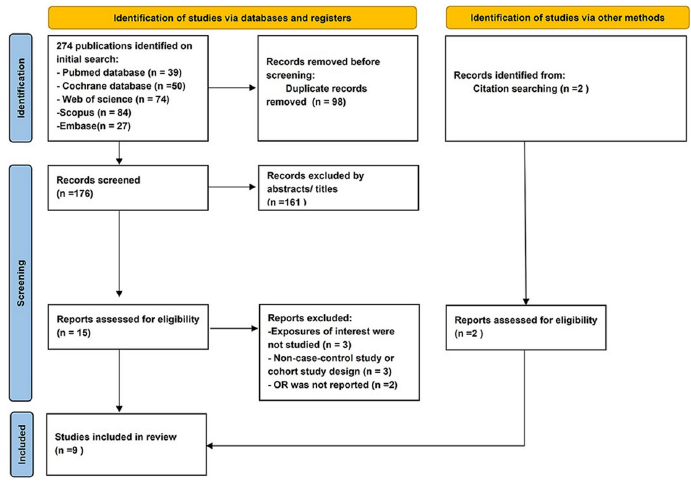
Fig 1. Prisma 2009 flow diagram literature search and study selection. PRISMA diagram showing the different steps of systematic review, starting from literature search to study selection and exclusion. The reasons for exclusion are indicated for each